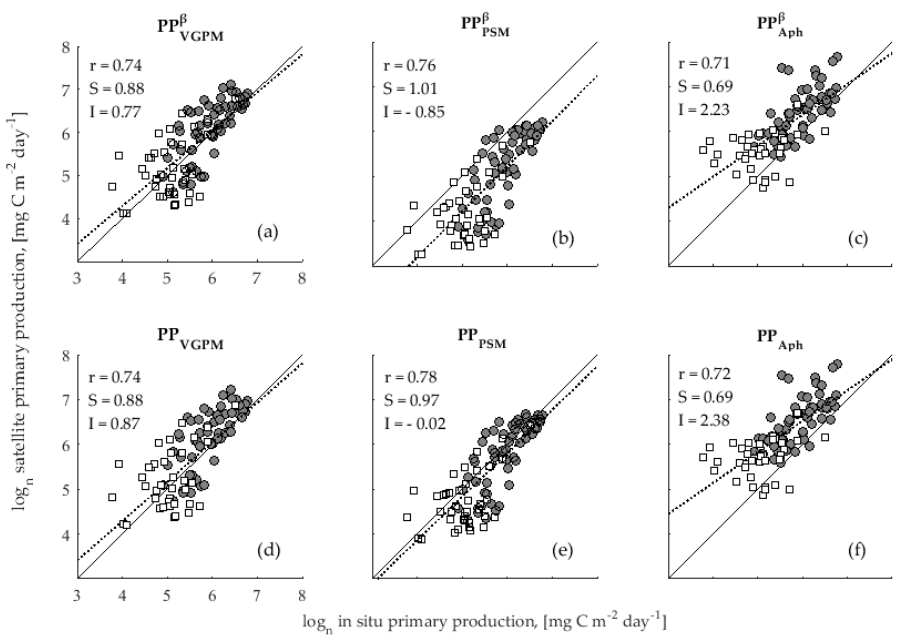
Figure 4. Scatter plots of log satellite and in situ PP eu [mg C m − 2 day − 1 ] in the NEA using eight day OC-CCI composites ( N = 95); ( a ) PP VGPM with photoinhibition, ( b ) PP PSM with photoinhibition, ( c ) PP Aph with photoinhibition, ( d ) PP VGPM with no photoinhibition, ( e ) PP PSM with no photoinhibition, and ( f ) PP Aph with no photoinhibition. Filled circles are data collected during summer; open squares are autumn data. Solid line is the 1:1 line; dotted line is the linear regression.